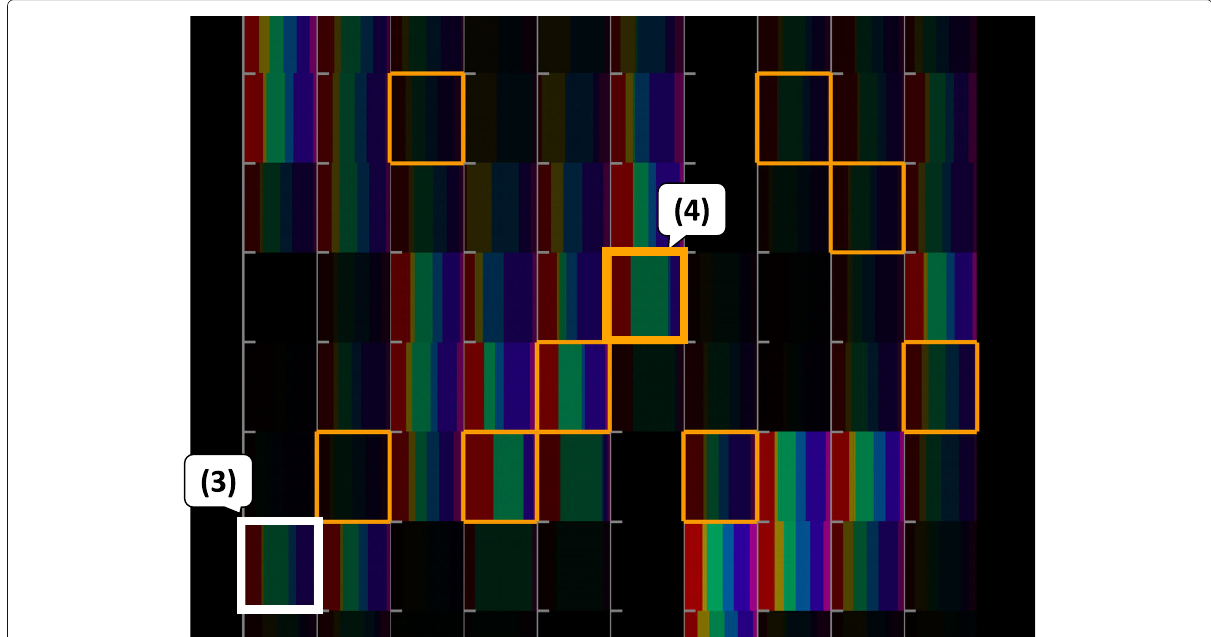
Fig. 9 Visual discovery of association rules based on the distribution and the intensity of component bar charts